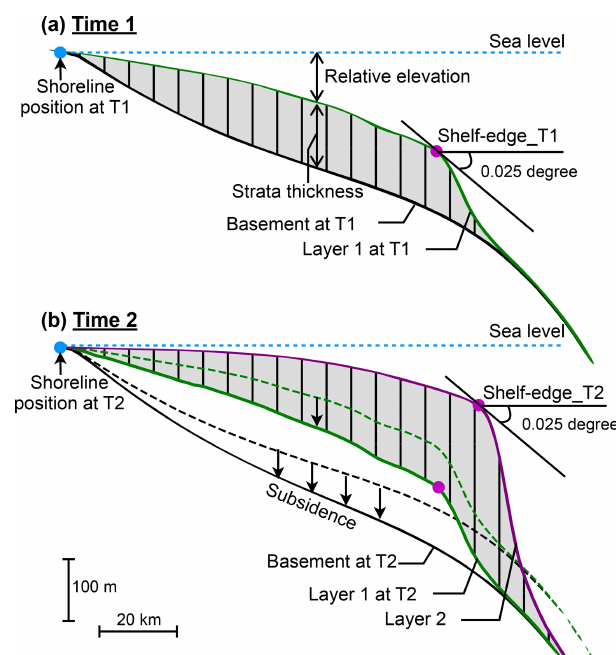
Figure 3. Schematic diagram showing the sedimentation from time 1 (T1) to time 2 (T2) under sea level variation and basement subsidence. The depth, relative elevation and thickness of strati- graphic layer are recorded at every time step ( dT = T2 − T1). Post- processing tools extract the shoreline and shelf-edge positions and calculate the rate of accommodation creation ( δA ) and the rate of sedimentation ( δS ) through time. The shoreline position is recorded by tracing the topographic contour that corresponds to sea level. The shelf edge is calculated by assuming a critical slope 0.025 ◦ . δA is calculated as changes in relative sea level at shoreline position over (T2 − T1): (sea level change + subsidence) / (T2 − T1); δS is calculated as deposited strata thickness at shoreline position over (T2 − T1): (strata thickness) / (T2 −